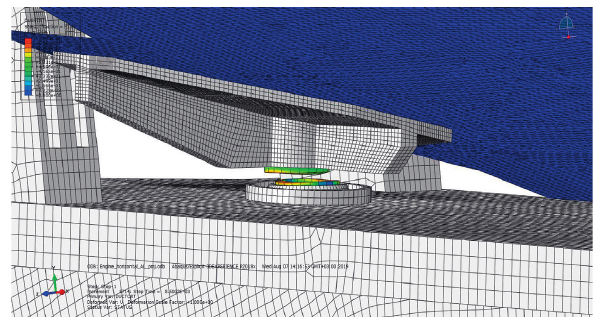
Figure 30: Damage to emergency disconnection device at central connection point—course of impact.